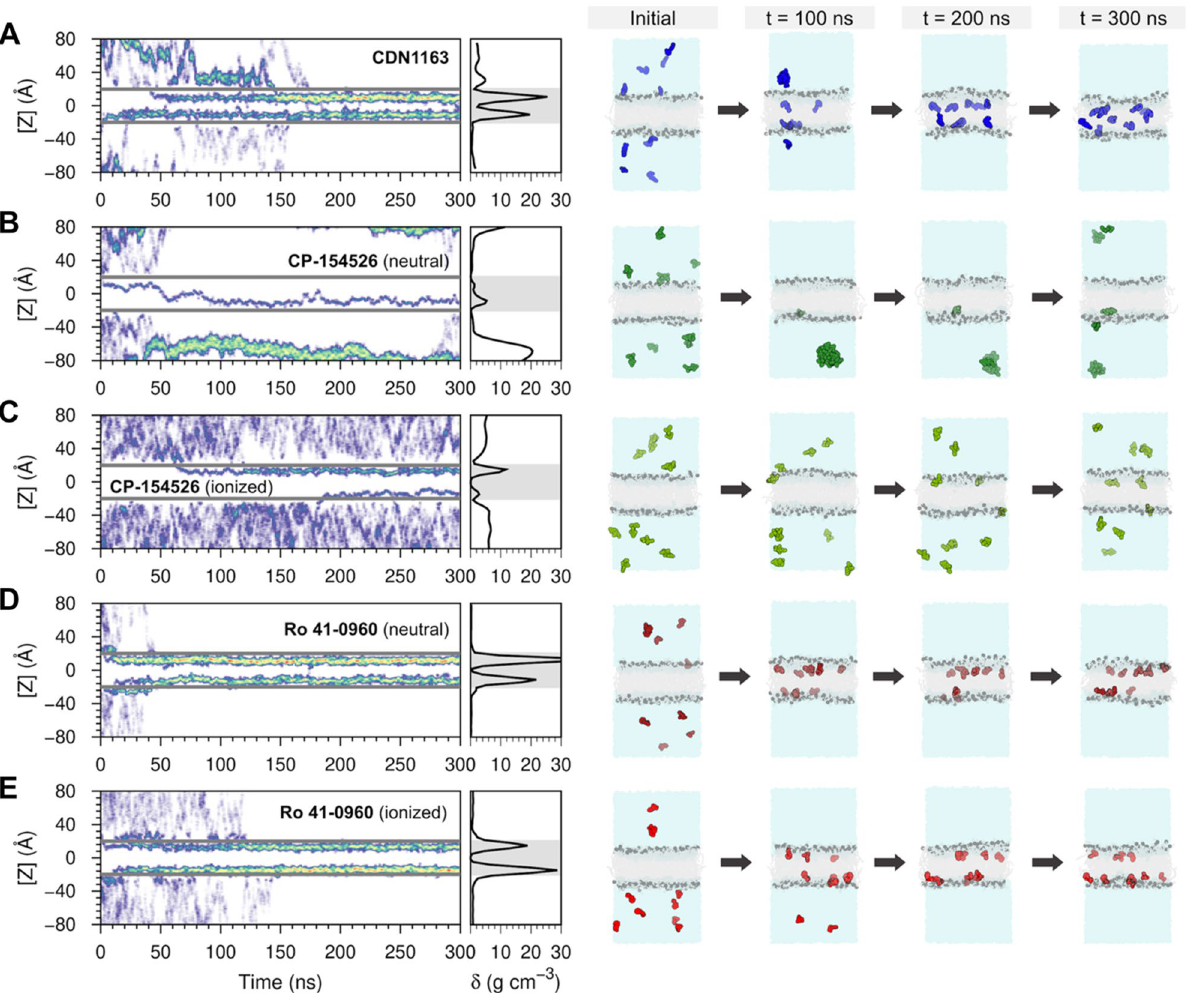
Figure 4. Ensemble-based atomistic simulations of ligand–membrane interactions of SERCA2a activators. The left panels show the time-resolved behavior of SERCA2a activators in a lipid–water environment and the relative density profiles of SERCA2a activators in a lipid–water system obtained from the ensemble-based MD simulations. The figure shows the position of the molecules relative to the z-axis of the system (left) and the relative density (δ) profile (right) calculated for ( A ) CDN1163, ( B , C ) CP-154526, and ( D , E ) Ro 41-0960. The gray horizontal lines (left) and the shaded area (right) represent the boundaries of the lipid bilayer. We show time-dependent configurations of each system containing a solvated membrane and ten copies of each SERCA2a actiator. The simulations capture spontaneous insertion of small molecules into the membrane as well as ligand–ligand interactions during the 300 ns of simulation time. CDN1163 (blue), CP-154526 (green), and Ro 41-0960 (red) are shown as spheres; lipids and water molecules are shown in gray and blue,